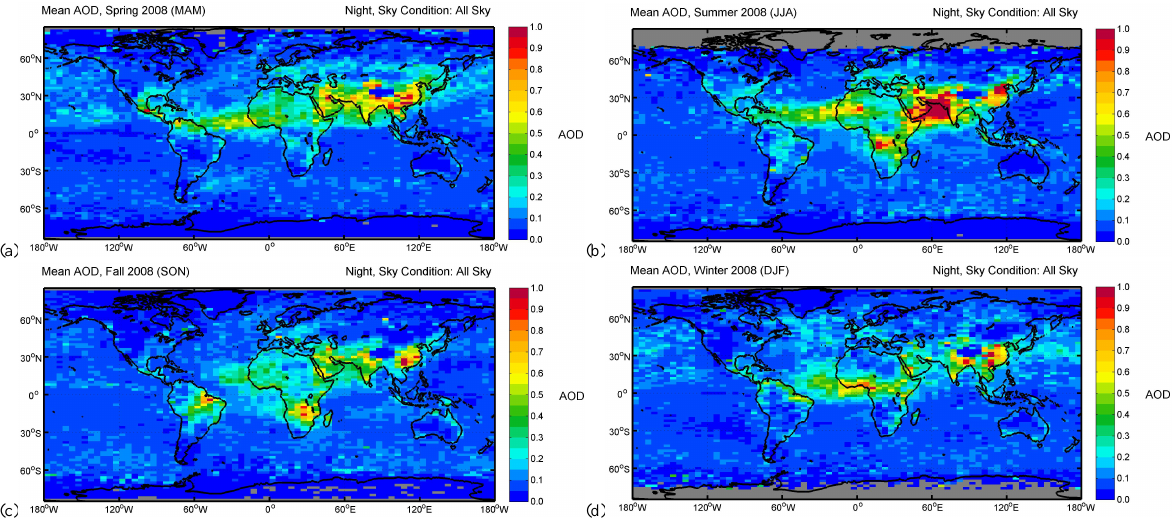
Fig. 10. Seasonal mean AOD for 2008, nighttime, all-sky: (a) MAM; (b) JJA; (c) SON; (d)